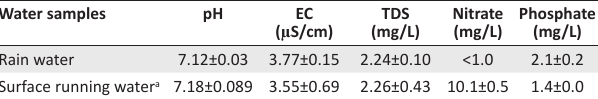
FIGURE 5: (a) Pavement brick with minimal presence of algae and (b) pavement brick with high levels of algae TABLE 2: The solar radiation at the study site on 27 January 2014. TABLE 1: The physical–chemical characteristic of the water samples collected on 27 January 2014. Replicates Water samples pH EC TDS ( µ S/cm)